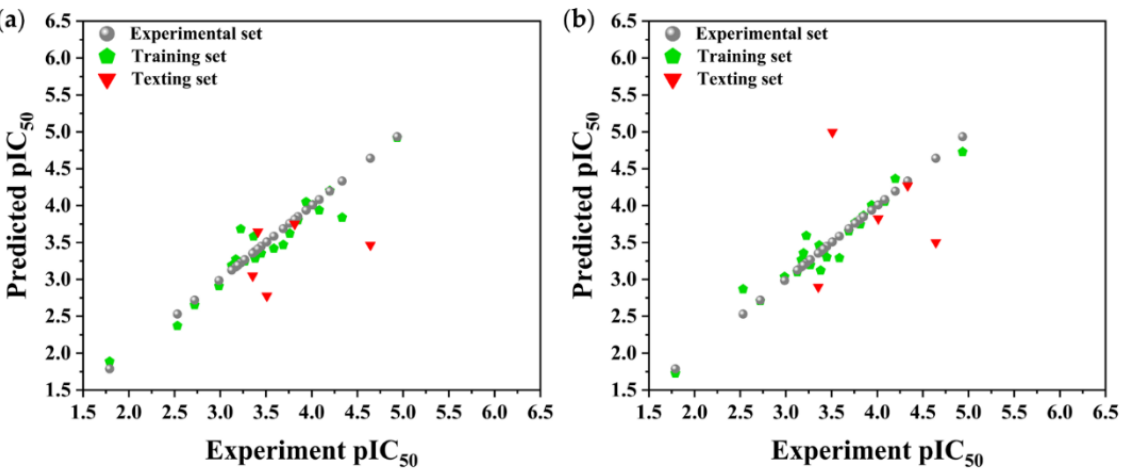
Figure 2. MLR-QSAR linear regression models. ( a ) 2D-QSAR model of dietary flavonoids. ( b ) 3D-QSAR model of dietary flavonoids.